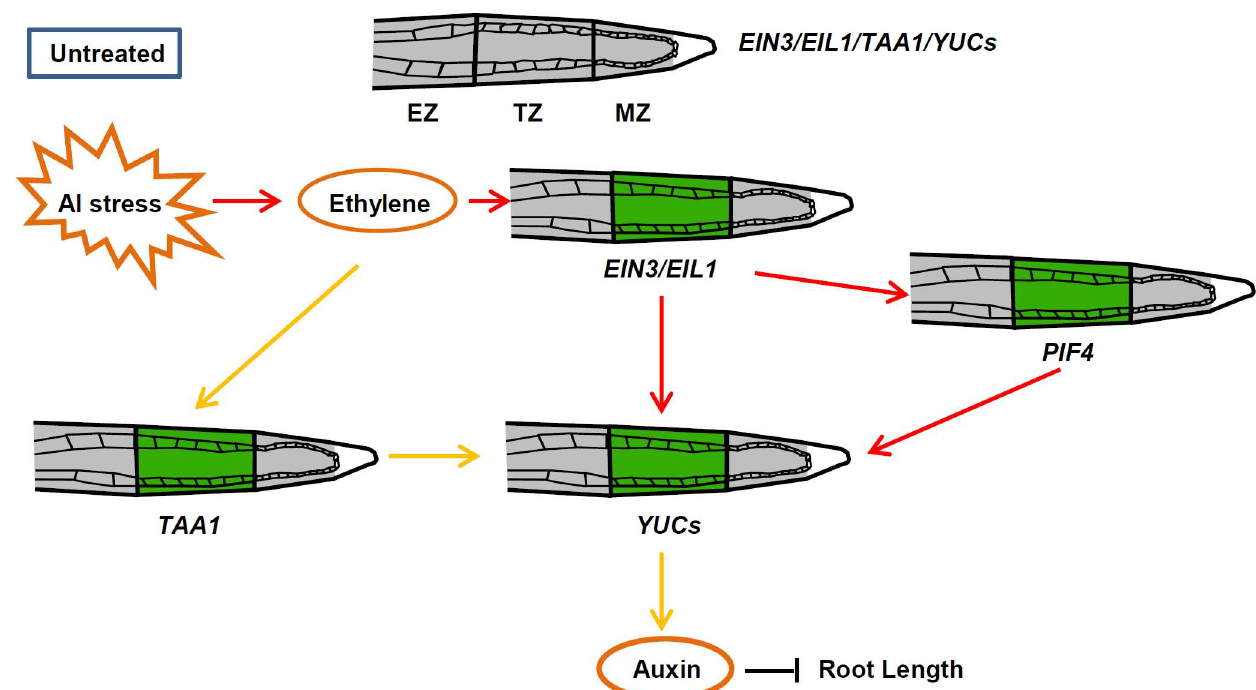
Fig 12. A Working model of YUC regulated root growth inhibition in response to Al stress. Al stress induces the local up-regulation of TAA1 and YUC s in the root TZ through an ethylene-dependent pathway. PIF4, which is specifically up-regulated in root TZ in response to Al stress, also participates into the local up-regulation of YUC s. The Al–inducedexpression of PIF4 in the root TZ acts downstream of ethylene signaling.The locally induced TAA1 and YUC s in response to Al stress contribute to auxin accumulation in the root TZ, which suppresses primary root growth. Green represents GFP signaling;EZ: Elongation zone; TZ: Transition zone; MZ: Meristem zone.